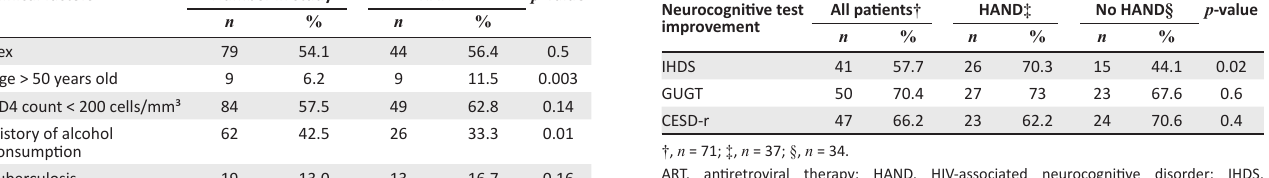
TABLE 2: Factors associated with HIV-associated neurocognitive disorder. Clinical factors